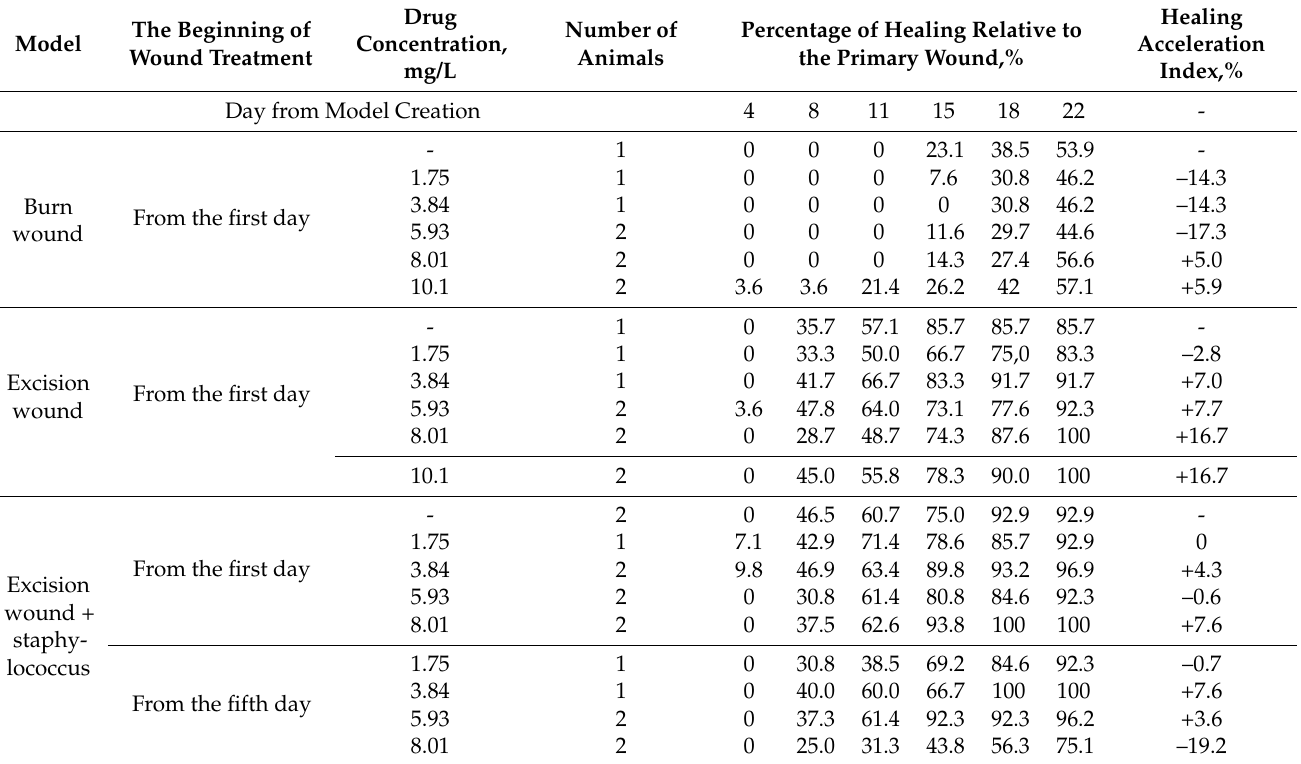
Table 4. Results of planimetric studies of